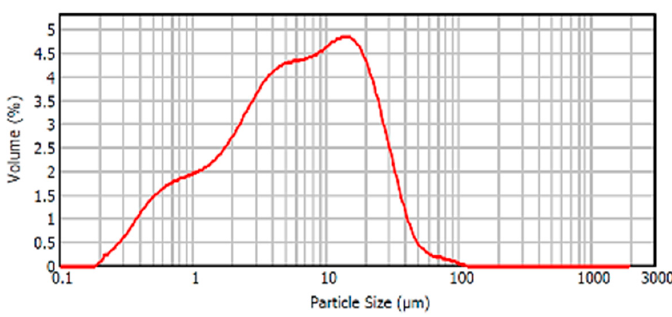
Figure 9. Particle size distribution SS.